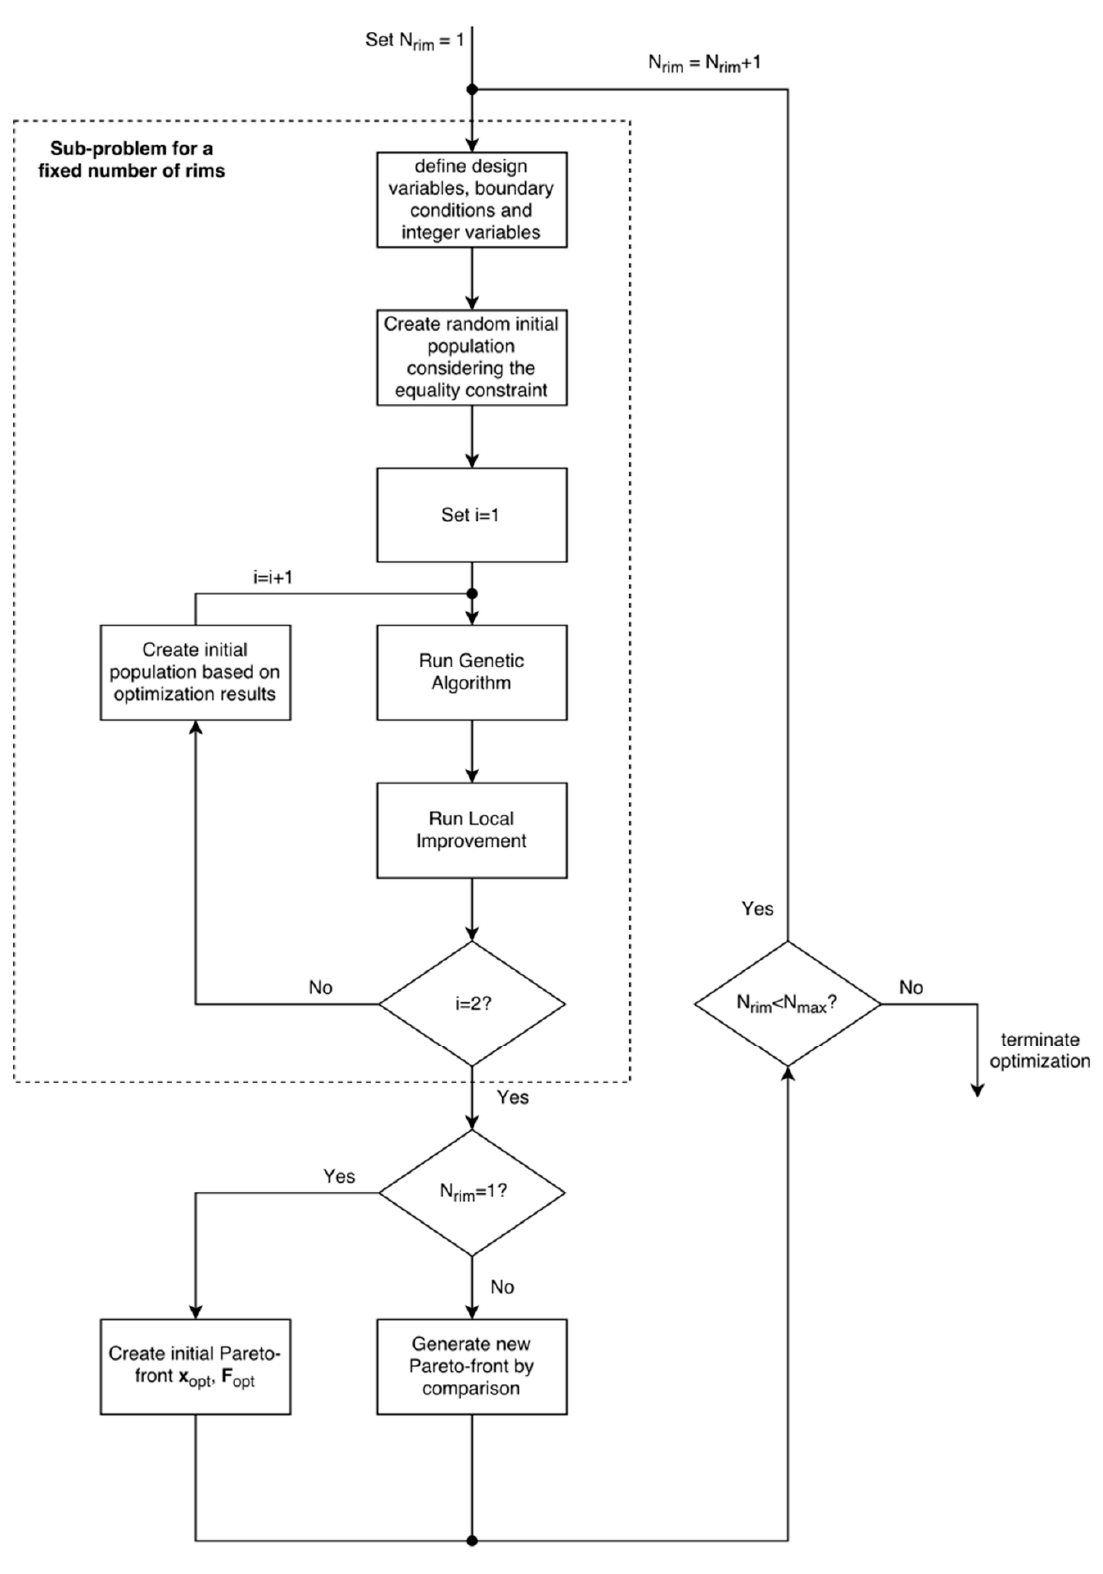
Figure 3. Schematic of the hybrid optimization.